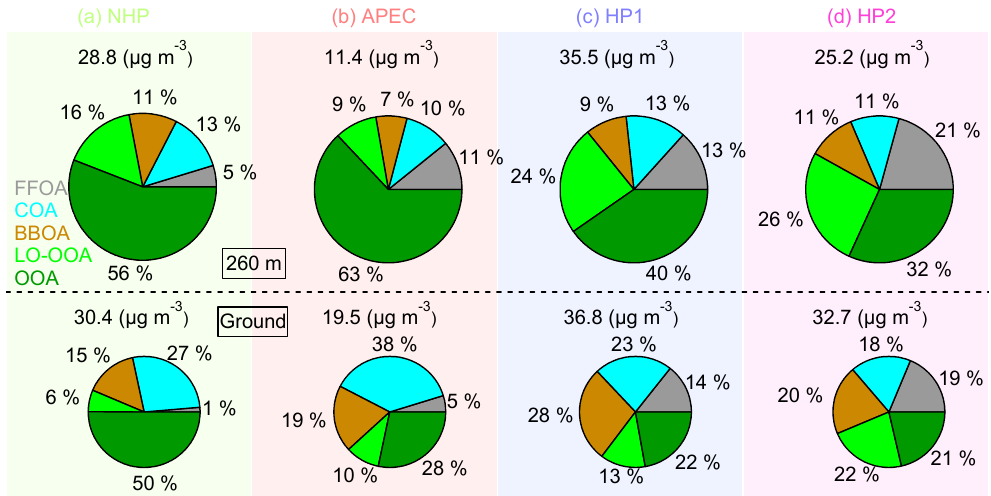
Figure 8. Average composition of OA during four different periods (a–d) , i.e., NHP, APEC, HP1, and HP2. The OA factors resolved at the ground site are also shown for comparison (bottom